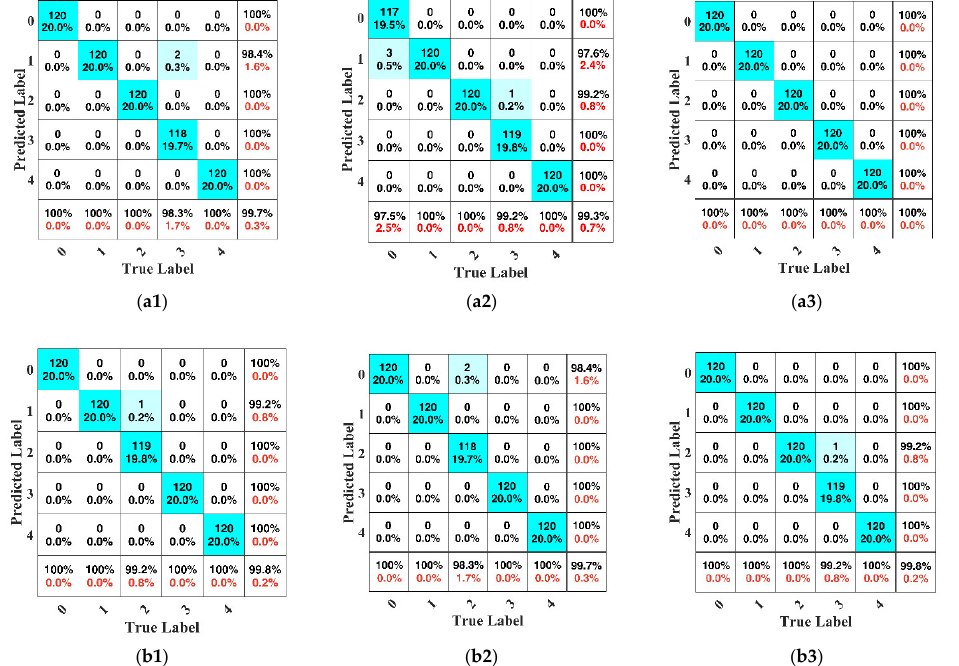
Figure 7. Confusion matrices of five wear fault conditions. ( a1 – a3 ) are the confusion matrices of the single-channel CNN method in testing datasets A, B, and C, respectively. ( b1 – b3 ) are the confusion matrices of the CAM_MCFCNN method in testing datasets A, B, and C, respectively.